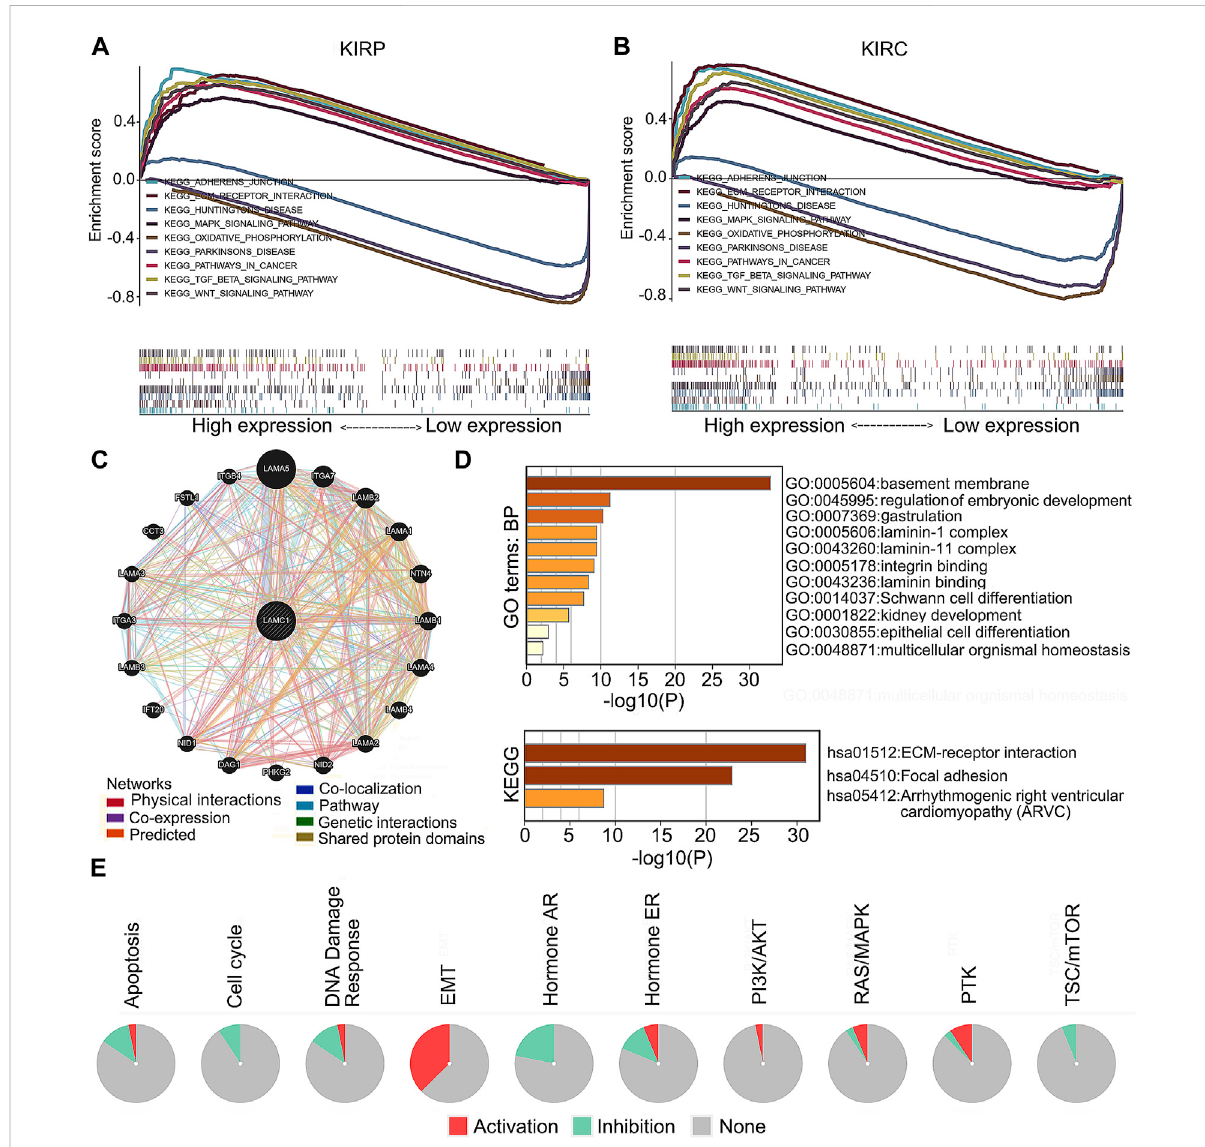
FIGURE 10 LAMC1 -associated signaling pathways, co-expression network and functional enrichment. (A,B) A pathway enrichment analysis of a rank- ordered gene list using theGSEA software for the high and low LAMC1 expressionin KIRP (A) and KIRC (B) . (C) The co-expression network of LAMC1 constructed by GeneMANIA. The node size represents the strength of interactions, and the line color represents the types of interactions. (D) Effect of LAMC1 on the biological processes. The histograms show the main biological processes in which LAMC1 interacting genes (as predicted by the GO and KEGG enrichment analyses) are involved, constructed using the Metascape portal (enrichment conditions: min overlap, three; p -value cutoff,0.01;minenrichment,1.5). (E) Effectof LAMC1 onthekeypathwaysincancersdetectedusingGSCALitedatabase.Redrepresentspromotion; green represents